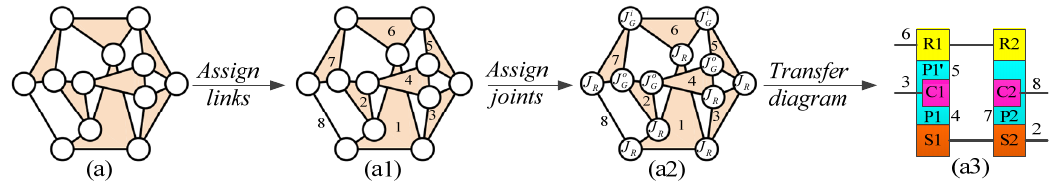
Figure 3. Process of specialization. ( a ) generalized kinematic chain; ( a1 ) specialized chain with identified all links; ( a2 ) specialized chain with identified all joints; ( a3 ) block diagram.